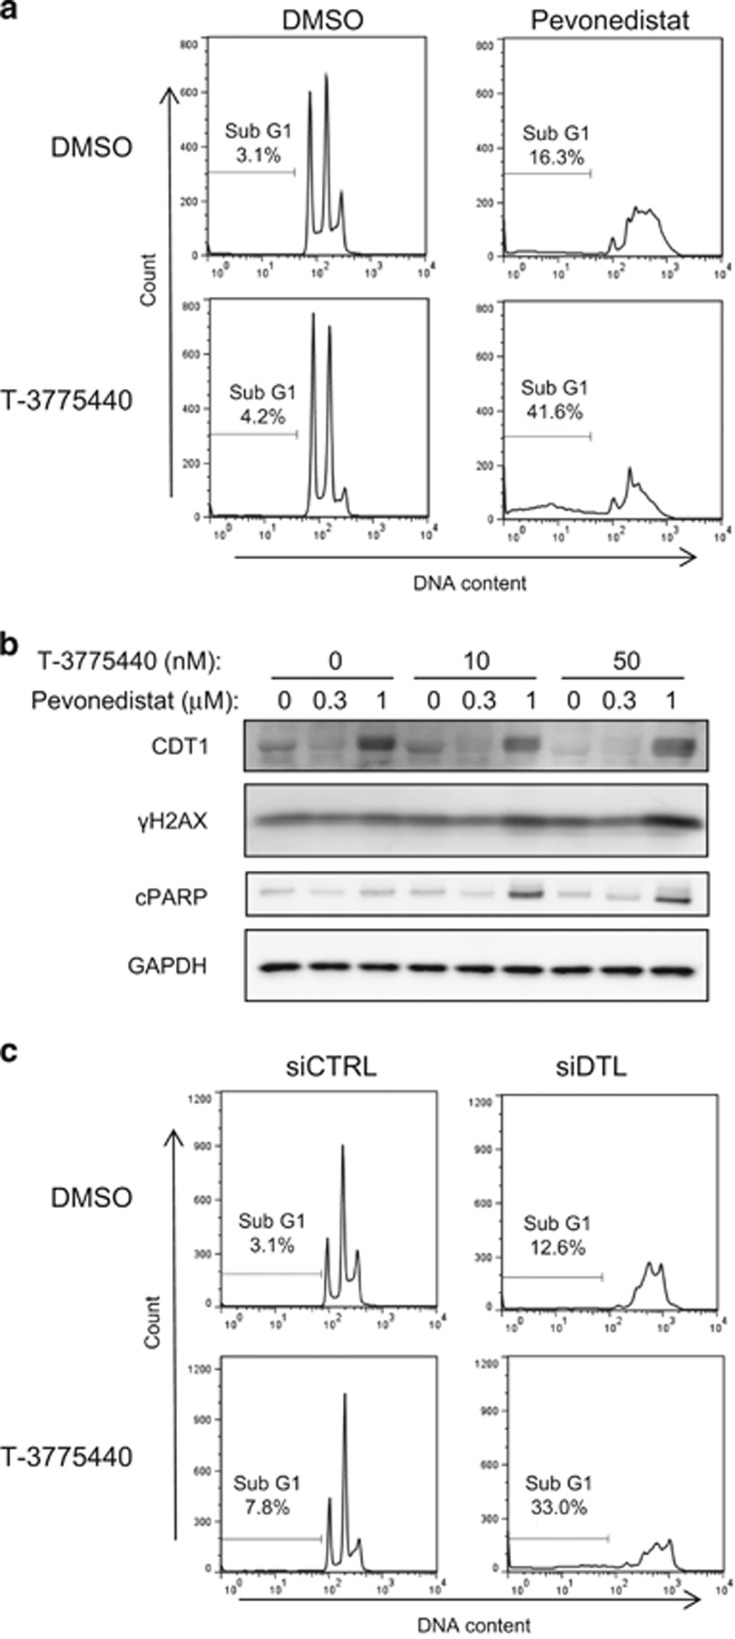
T-3775440 enhances apoptotic cell death under pevonedistat- or DTL depletion-induced replication stress. (a) TF-1a cells were treated with vehicle, 50 nm T-3775440, 1000 nm pevonedistat, or T-3775440 and pevonedistat for 48 h. DNA content was determined by flow cytometry. Note that this cell line grows as a stable population of cells with n, 2n and 4n nuclear complements. Percentages of cells in the sub-G1 population are indicated. (b) Increased DNA damage and apoptosis after T-3775440 and pevonedistat treatment. TF-1a cells were treated with drugs or dimethyl sulfoxide (DMSO) control (as indicated) for 48 h. Immunoblotting analysis was performed to determine the expression levels of γH2AX and cleaved PARP. Glyceraldehyde 3-phosphate dehydrogenase (GAPDH) was used as a protein-loading control. (c) TF-1a cells were transfected with siRNA targeting DTL or control siRNA and incubated for 4 h. Next, cells were replated in the presence or absence of 50 nm T-3775440 for 48 h. Cell cycle analysis was performed using flow cytometry.